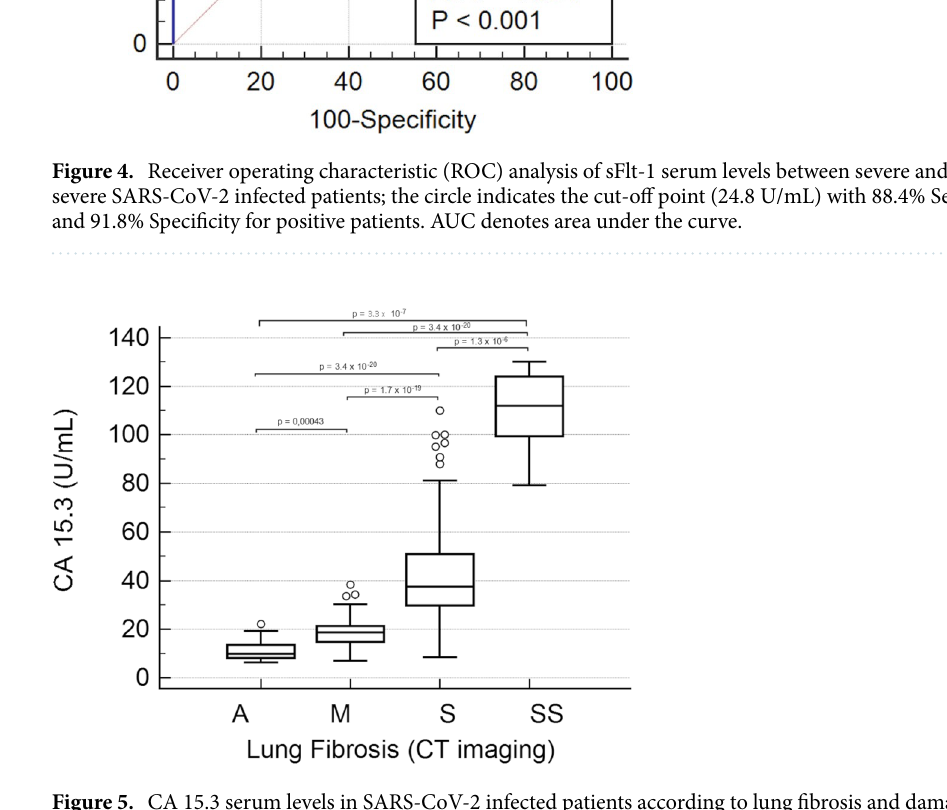
Figure 5. CA 15.3 serum levels in SARS-CoV-2 infected patients according to lung fibrosis and damage severity grade obtained by CT imaging. A, absence of lung fibrosis; M, moderate grade; S, severe grade; SS; critic grade. Boxes represent first and third quartiles (25 to 75 percentile), bands within boxes represent the median value, whiskers display ranges of 1.5 interquartile ranges from the end of the box, outside values are displayed as separate